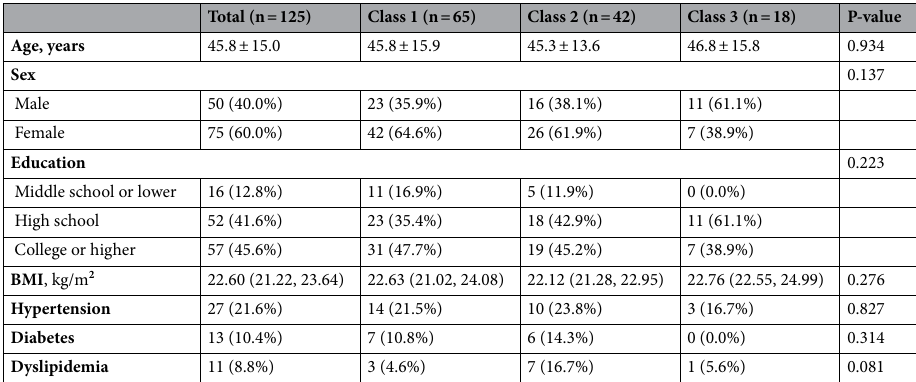
Table 2. Sociodemographic, anthropometric and metabolic characteristics of participants with migraine. Data are presented as the mean ± standard deviation, median (interquartile range), or n (%). BMI body mass index. Statistical method for comparison of the three groups: one-way analysis of variance for normally distributed variables; Kruskal–Wallis test for non-normally distributed variables; Chi-square or Fisher’s exact test for categorical